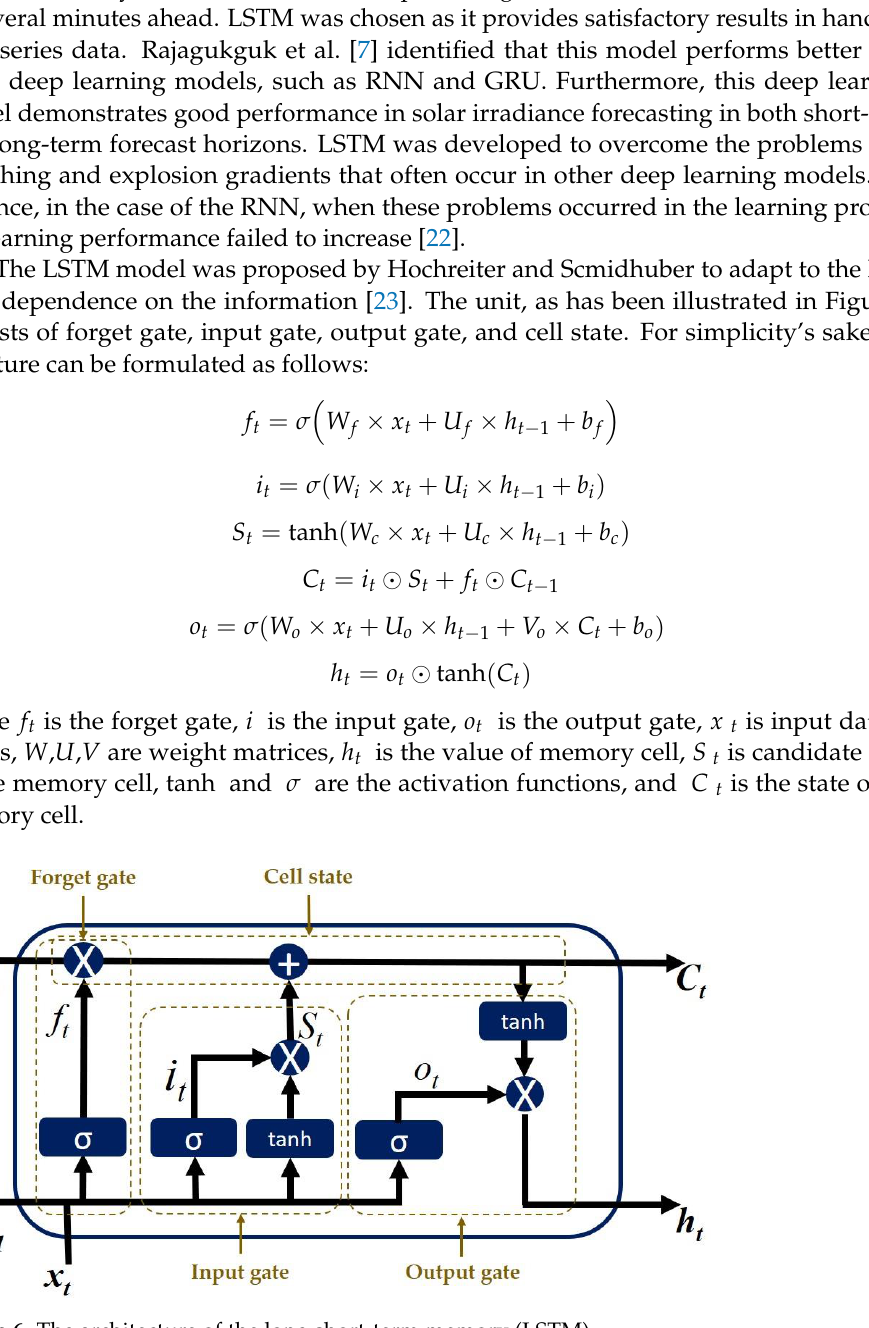
Table 2. The hyperparameters used in designing the LSTM model. Hyperparameter Searching for Optimal Value